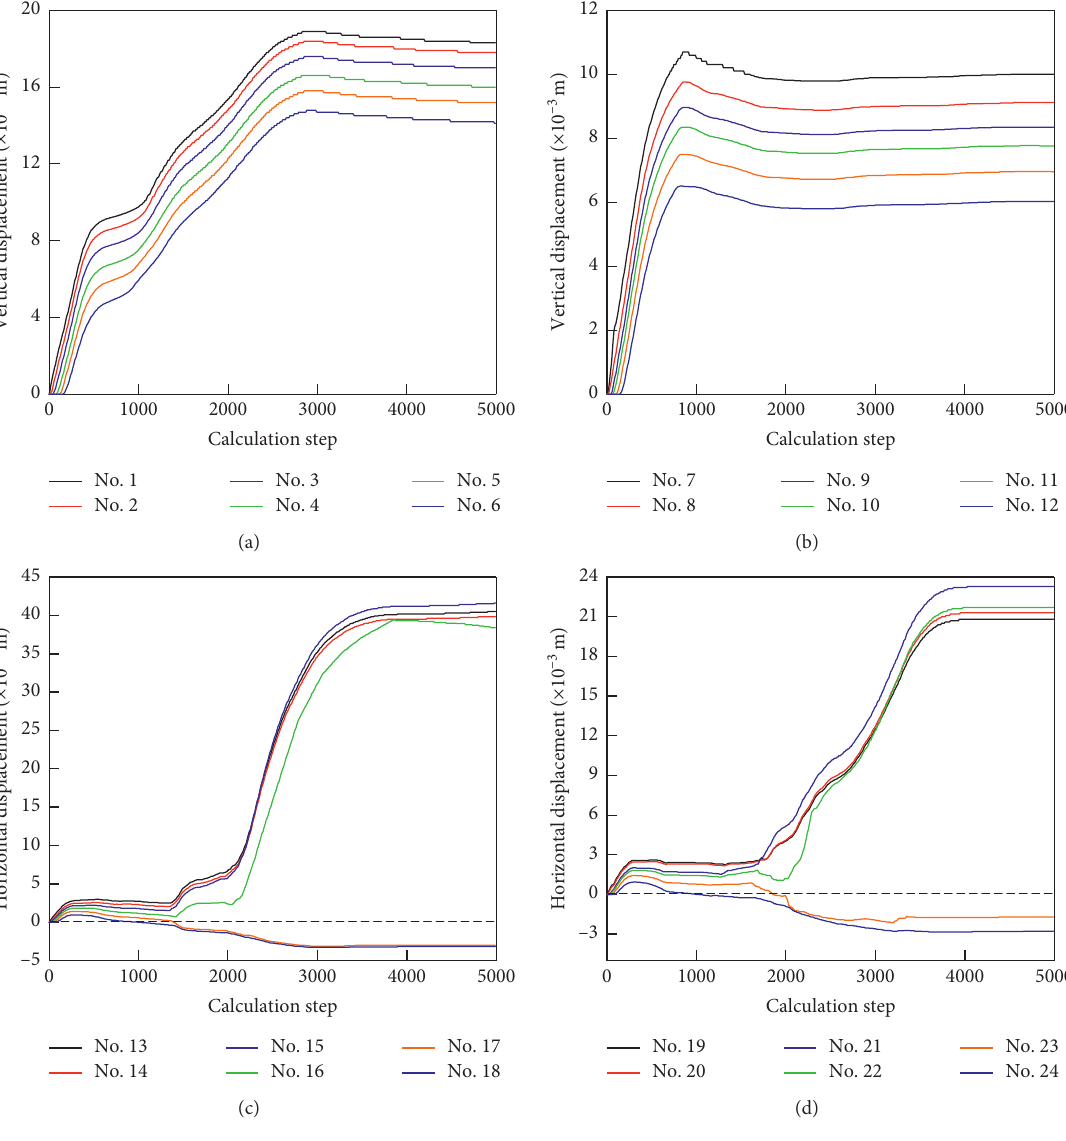
Figure 12: Displacement monitoring curves for the roadway. (a) Roof, (b) floor, (c) left wall, and (d) right